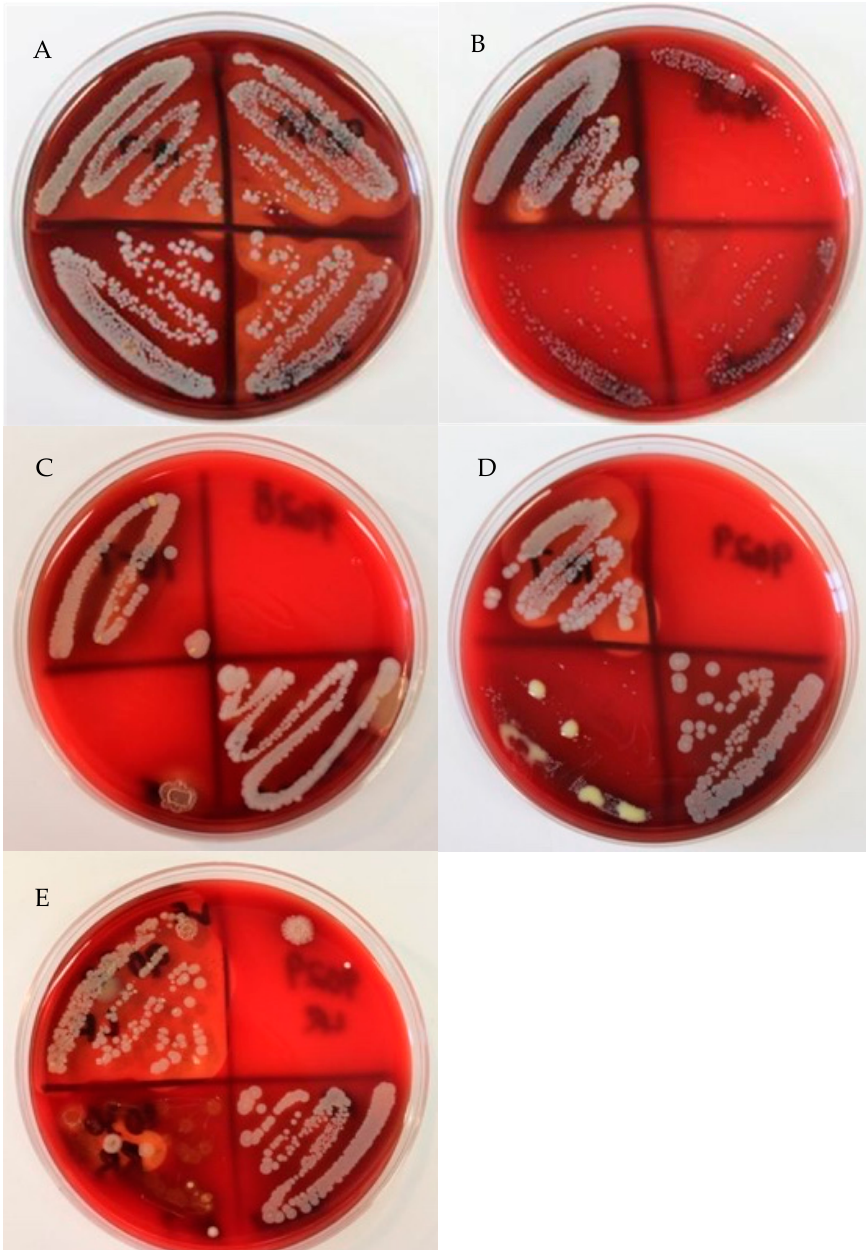
Figure 2. ( A ) Four quarter mammary secretions showing 3 quarters with hemolytic S. aureus (top left, top right, and bottom right) and 1 quarter nonhemolytic S. aureus (bottom left). ( B ) Four quarter mammary secretions showing 1 quarter with nonhemolytic S. aureus (top left). There is 1 area of hemolytic contamination (small Gram-positive Bacillus ) in this mammary secretion streak. Though outside the scope of the report, the remaining 3 quarters show environmental streptococci. ( C ) Four quarter mammary secretions showing 1 quarter nonhemolytic S. aureus (top left) and 1 quarter coagulase-positive staphylococci (CPS) ( S. intermedius , bottom right). ( D ) Four quarter mammary secretions showing 1 quarter hemolytic S. aureus (top left) and 1 quarter nonhemolytic S. aureus (bottom right). These particular nonhemolytic S. aureus have distinct cream-colored centers on a greyish-white colony. ( E ) Four quarter mammary secretions showing 1 quarter hemolytic S. aureus (yellower in color than other hemolytic S. aureus found, top left) and 1 quarter nonhemolytic S. aureus (bottom right). These particular nonhemolytic S. aureus also have distinct cream-colored centers on a greyish-white colony (similar to those seen in Figure 2D).